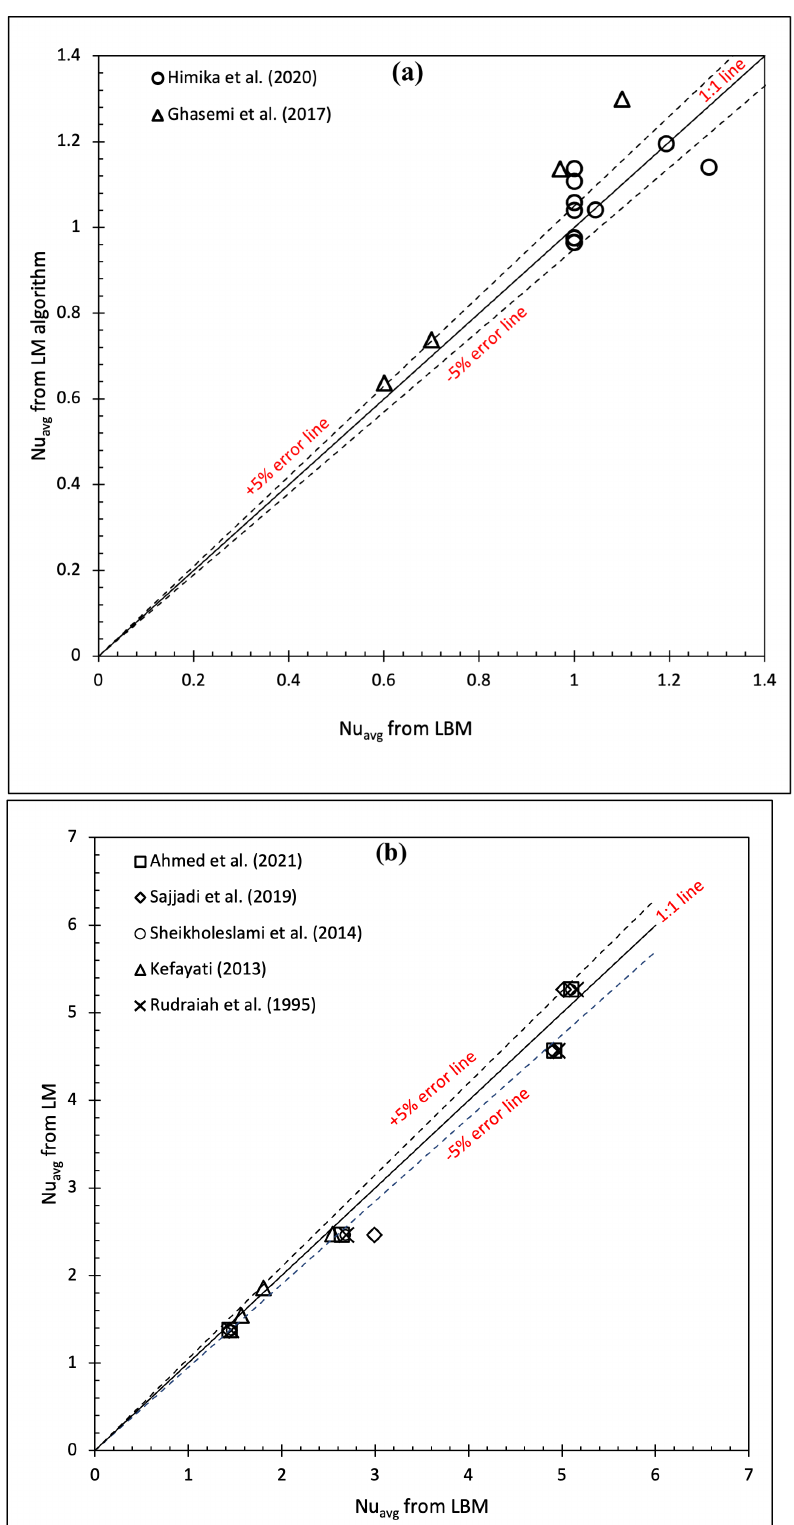
Figure 8. Surface fitting curves obtained from LBM data by LM algorithm for ( a ) Ra = 10 4 [18,64], and ( b ) Ra = 10 5 [16,44,59,61,62], while (cid:101) = 0.4, θ = 45 were